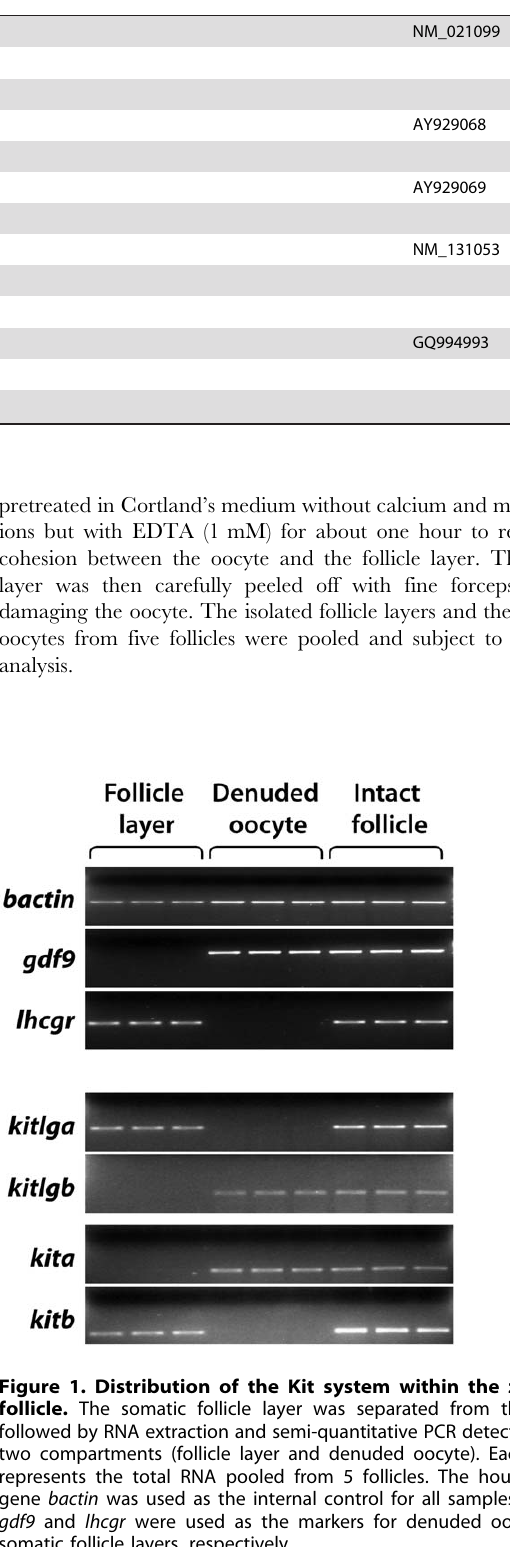
Gene Accession No.